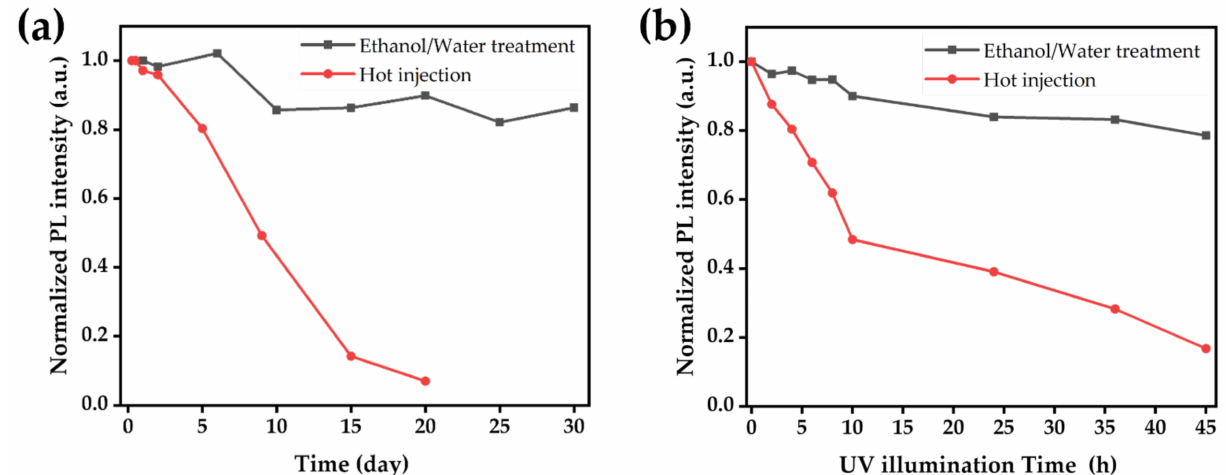
Figure 8. ( a ) Time-dependent PL spectra of the CsPbBr 3 MC solution obtained via the ethanol/water treatment and hot-injection method under ambient conditions, and ( b ) PL spectra of the CsPbBr 3 MC so- lution obtained via the ethanol/water treatment and high-temperature injection under UV